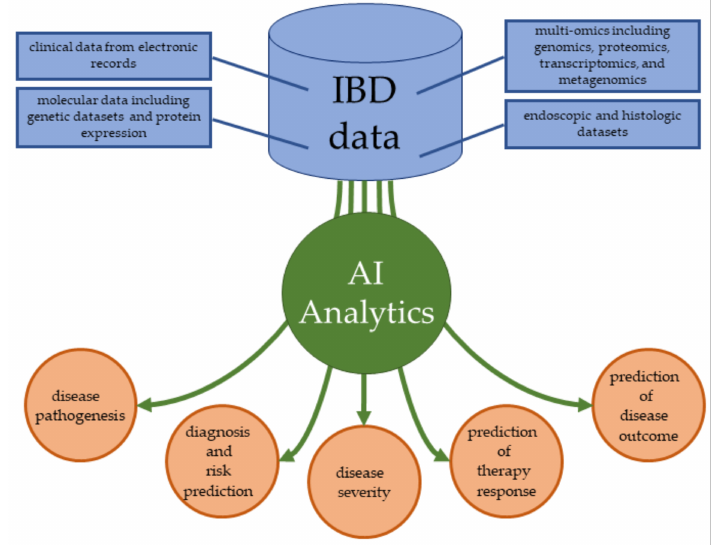
Figure 7. Location of artificial intelligence (AI) in the medical management of inflammatory bowel disease as proposed by Gubatan et al. [21]. IBD, inflammatory bowel